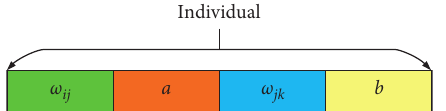
Figure 3: The diagram of real number coding of individual. The weights ω ij and ω jk and thresholds a and b are arranged serially in a single individual.